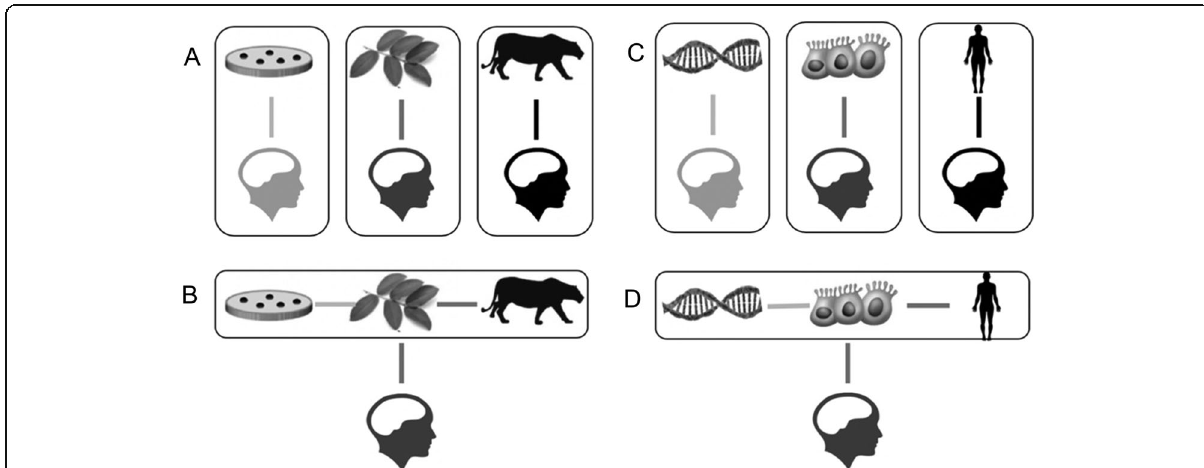
Fig. 4 One example of unity and diversity in biological reasoning. Note that examples using a broader set of scales (e.g., ecosystem) could be utilized. a Within a biological scale (in this case, the scale of organism), reasoning about living systems lacks unification and is organized by taxonomic contexts, experiential instances, and case examples. b Within a biological scale (in this case, the scale of organism) reasoning about living systems is characterized by abstract models transcending organismal type or lineage (i.e. conceptual unity). c Among biological scales (in this case, molecule, cell, organism), reasoning about living systems lacks unification and is organized by macroscopic (organismal), microscopic (cellular), and molecular (biochemical) levels of biological organization. d Among biological scales (in this case, molecule, cell, organism), reasoning about living systems at is characterized by abstract models linking biological scales (i.e. conceptual